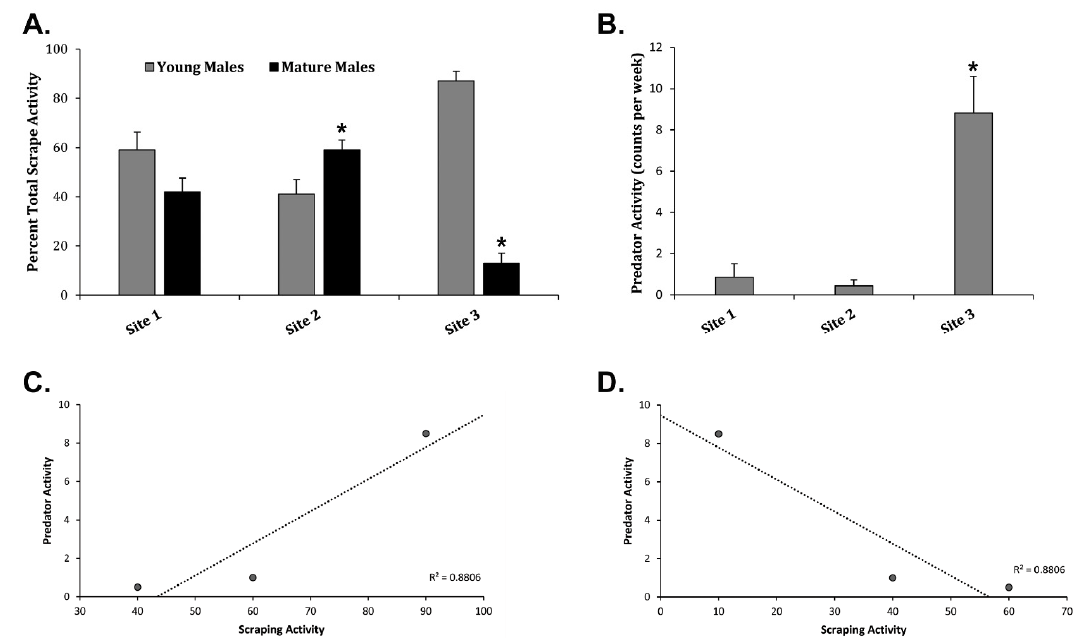
Figure 6. Influence of Predation on Scraping Activity. ( A ) The graph shows the Avg ± Stdev of the percentage of total scrape activity among young males and mature males at Sites 1, 2, and 3. ( B ) The graph displays the Avg ± Stdev of predator activity in counts per week at Sites 1, 2, and 3. Statistical analysis was performed using a one-way ANOVA test, where * p < 0.05 was considered significant. ( C ) The graph displays young male scraping activity plotted against predator activity with a correlation coefficient of 0.88. ( D ) The graph displays mature male scraping activity plotted against predator activity with a correlation coefficient of 0.88.